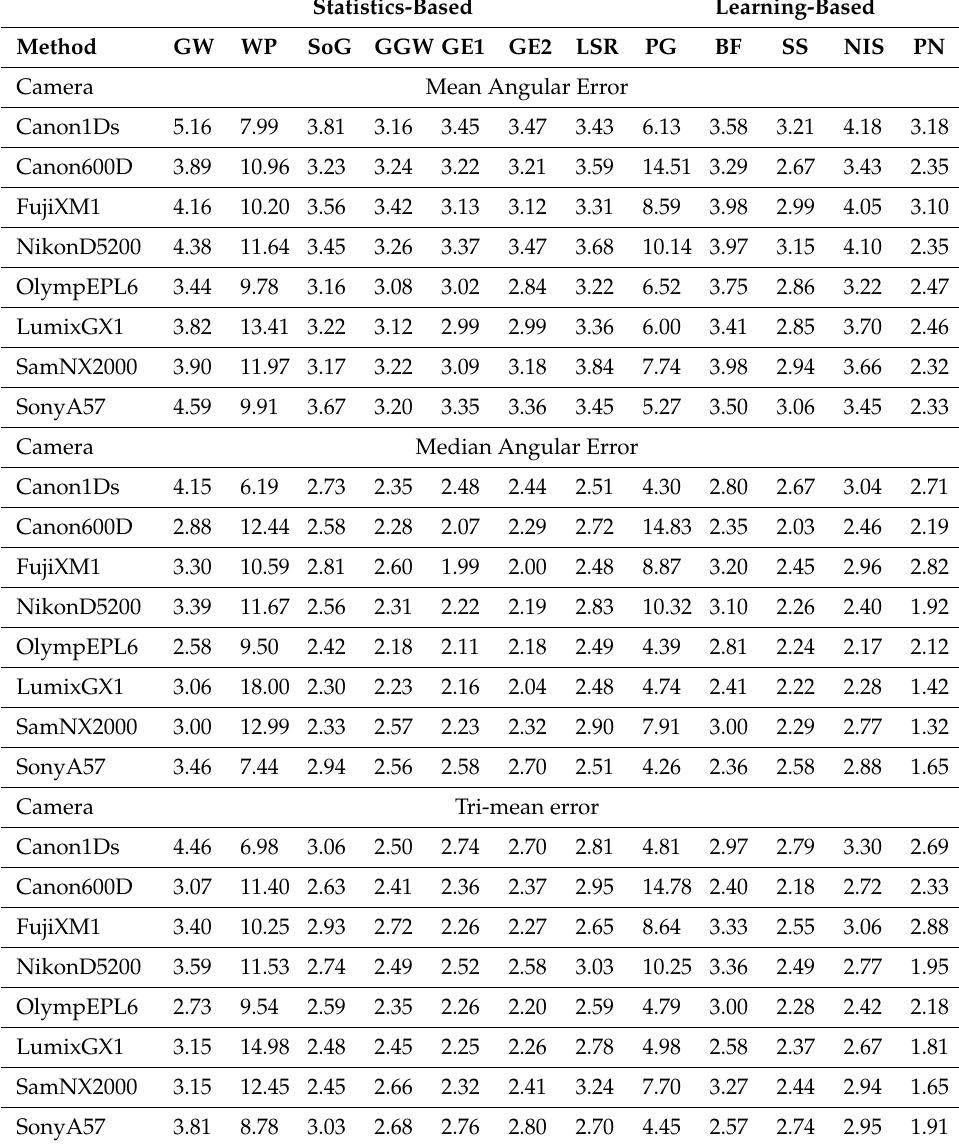
Table 2. Performance comparison between grey world (GW) [32], white patch (WP) [3], shades of